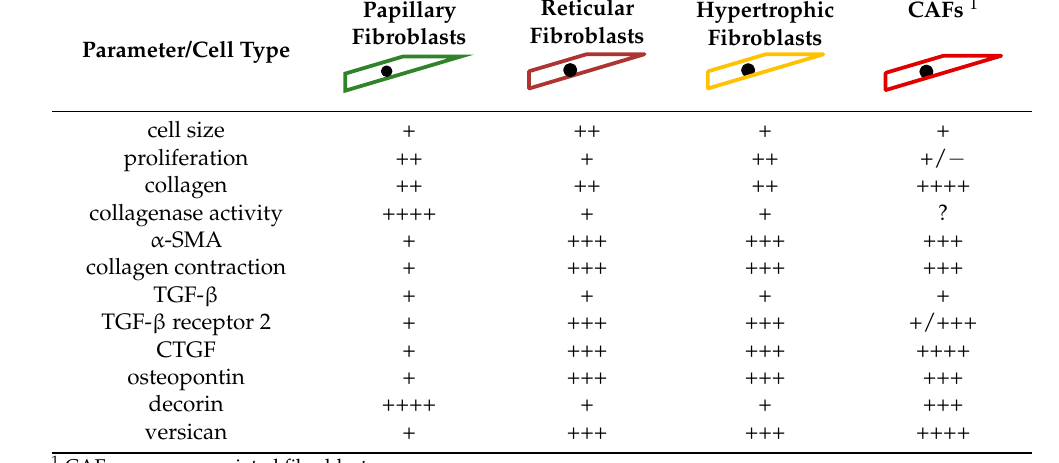
Table 1. Currently known differences between the main subpopulations of skin fibroblasts ( − absent; + minimal; ++ mild; +++ moderate, ++++ marked, ? unknown). Parameter/Cell Type